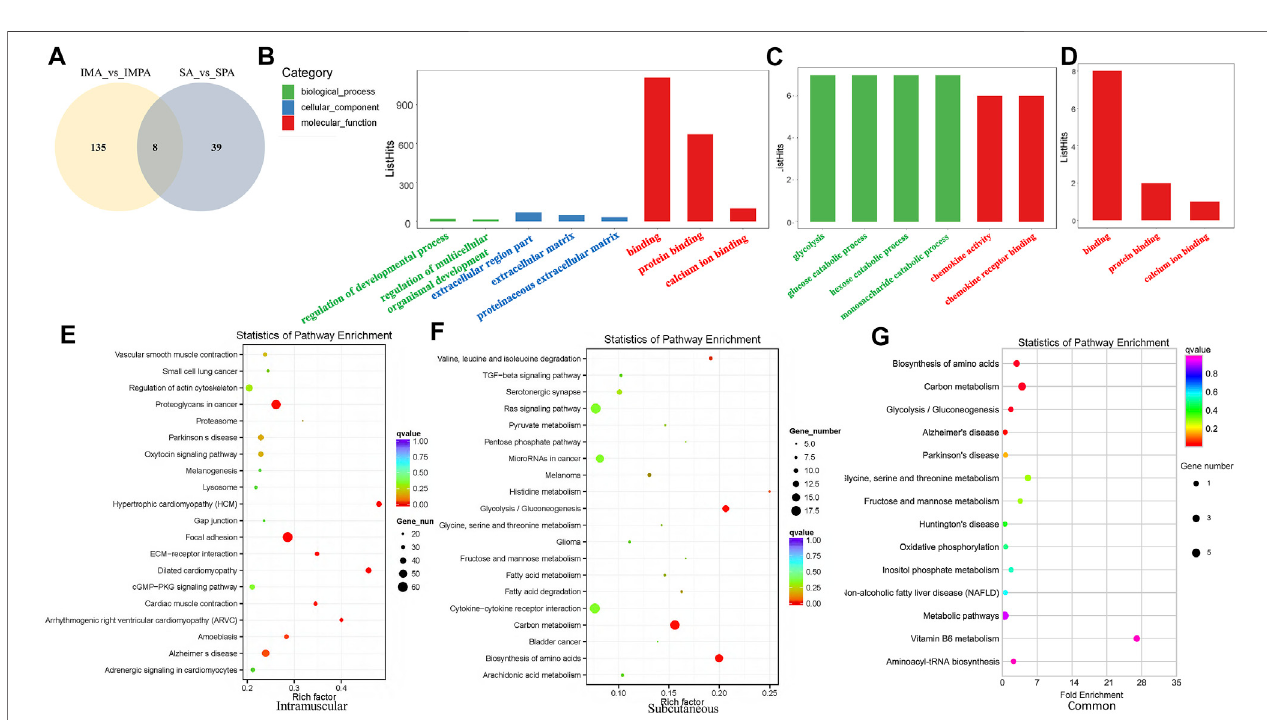
FIGURE 4 | GO and KEGG enrichment analyses of differentially expressed lncRNAs in goat different adipocytes. (A) Venny maps of differentially expressed lncRNAs during intramuscular and subcutaneous preadipocyte differentiation. (B) Categories of biological processes, cellular components and molecular functions of thetargetgenesofdifferentiallyexpressedlncRNAs(intramuscularadipocytes). (C) Categoriesofthebiologicalprocessesandmolecularfunctionsofthetargetgenesof differentially expressed lncRNAs (subcutaneous adipocytes). (D) Categories of molecular functions of the target genes of differentially expressed lncRNAs (both subcutaneous and intramuscular adipocytes). (E) Scatter plot of the top 20 pathways enriched for differentially expressed lncRNAs in intramuscular adipocytes before andafterdifferentiation. (F) Scatterplotofthetop20pathwaysenrichedfordifferentiallyexpressed lncRNAsinsubcutaneousadipocytesbeforeandafterdifferentiation. (G) Scatterplotofthetop15pathwaysenrichedfordifferentiallyexpressed lncRNAsinbothintramuscularandsubcutaneousadipocytesbeforeandafterdifferentiation. The abscissa represents the richness factor, and the ordinate represents the enriched pathway terms. The Q-value represents the corrected p value.